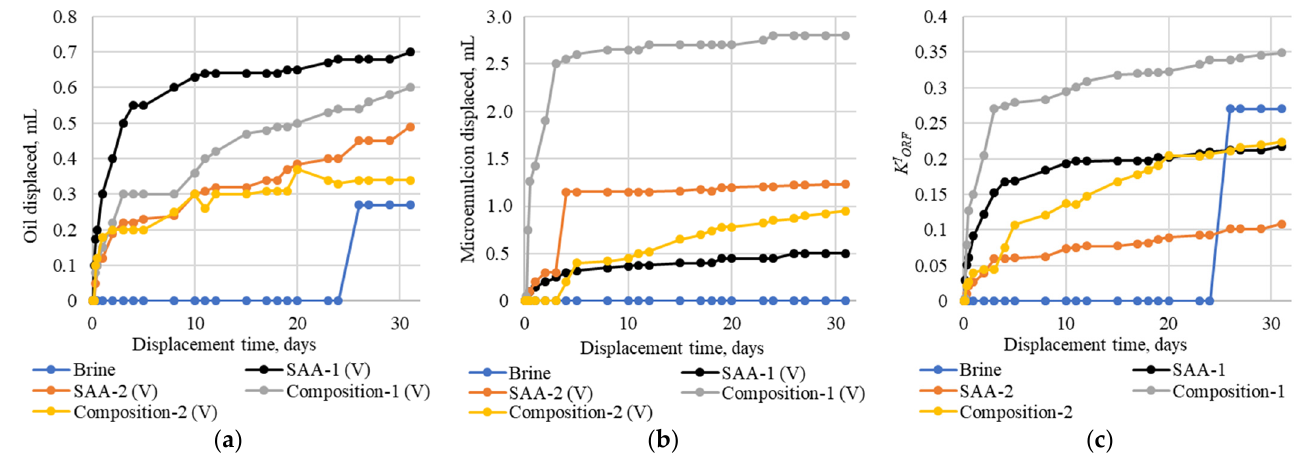
( c ) Figure 7. Displacement rate and oil displacement coefficient during capillary impregnation for